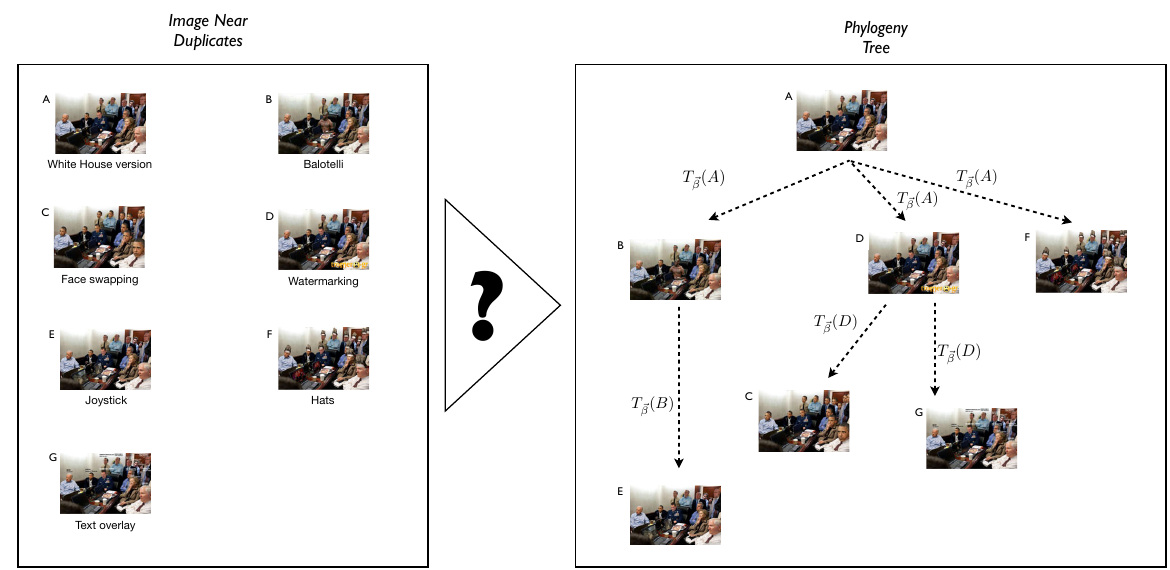
Fig.12. ReconstructionoftheimagephylogenytreeofimagescollectedfromtheInternetportraying TheSituation Room episode.ThisIPTwasreconstructedusingE-AOBmethod. Figure 10 - IPT construction example using images collected from the Internet about “The Situation Room” episode. Adapted from (Oikawa et al.